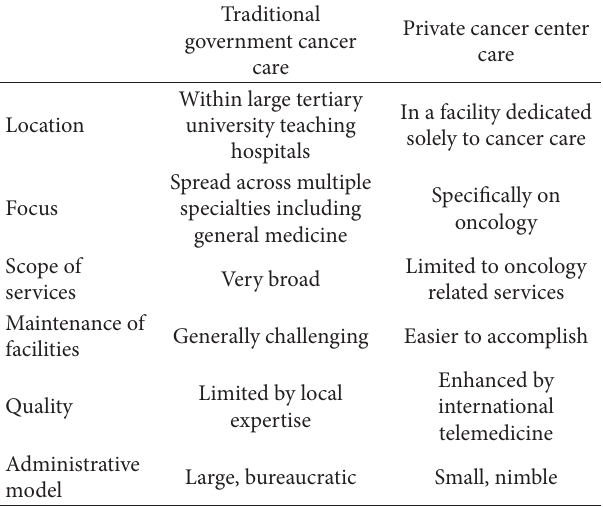
Table 1: Public versus private cancer